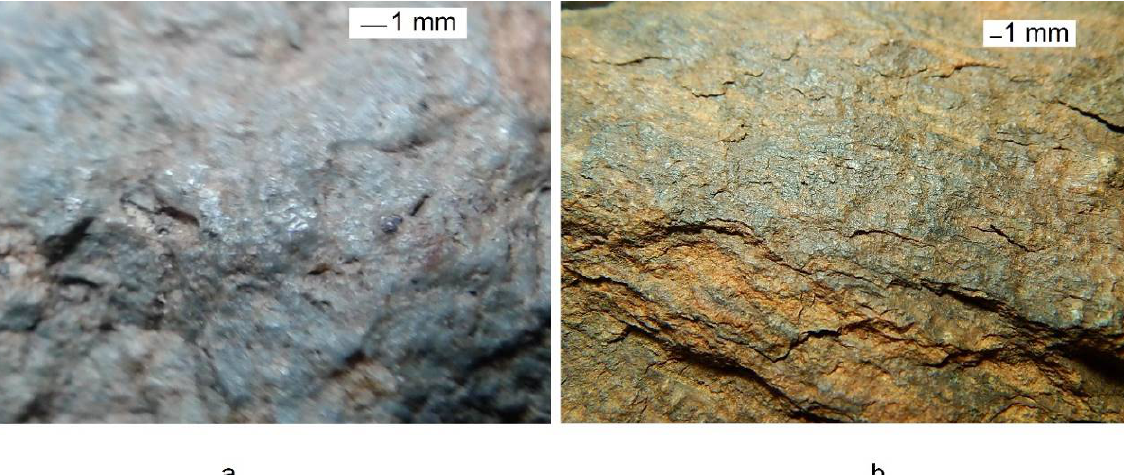
Figure 5. (a) localized polish behind the working edge of Specimen 7; and (b) diffuse polish near the center of the face of Specimen 19. (Photographs by Steve